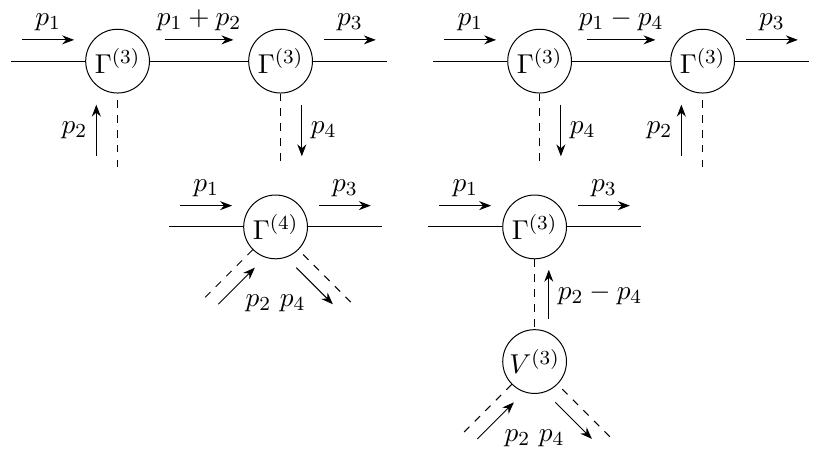
Figure 4 . The set of diagrams contributing to the T AB → AB amplitudes. Here the solid lines represent scalar particles A and dashed lines represent dilatons B